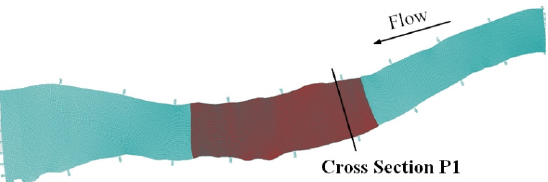
Figure 6. River reach where the modified ISSDOTv2 method was applied (red area).